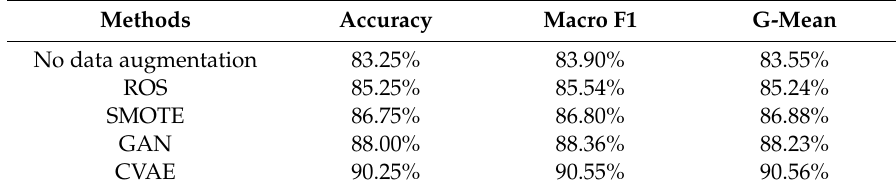
Table 4. Results of the test set under di ff erent data augmentation